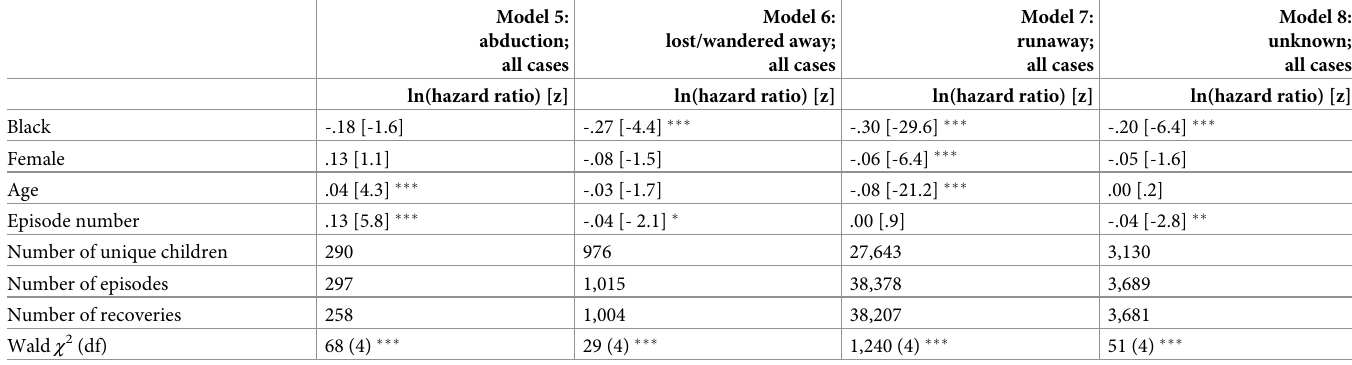
Table 4. Survival models regressing recovery hazard of children who were abducted, were lost, ran away or whose status is